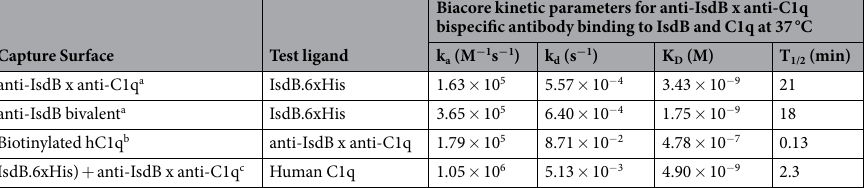
Table 1. Binding parameters for anti-IsdB x anti-C1q. Anti-IsdB x anti-C1q bsAb binds to C1q with low affinity and IsdB with high affinity. This bsAb was produced with one arm recruiting C1q and the other arm targeting the IsdB antigen present on the surface of S . aureus . The bsAb was characterized using Biacore. a IsdB.6xHis was injected across an Fc-captured anti-IsdB x anti C1q chip surface. b anti-IsdB x anti-C1q bsAb was injected across a streptavidin-captured biotinylated human C1q chip surface. c anti-IsdB x anti-C1q bsAb and human C1q were sequentially injected across a chip surface of captured IsdB.6xHis